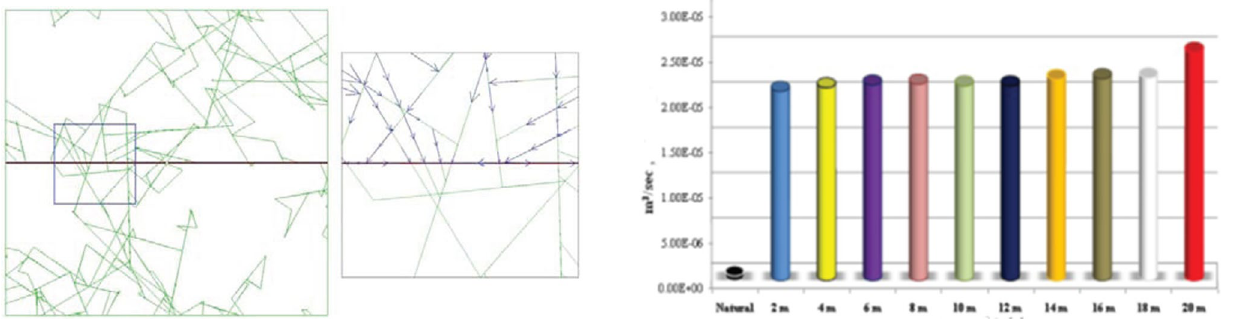
Fig. 15 Production rate in normal conditions and hydraulic fracture with different